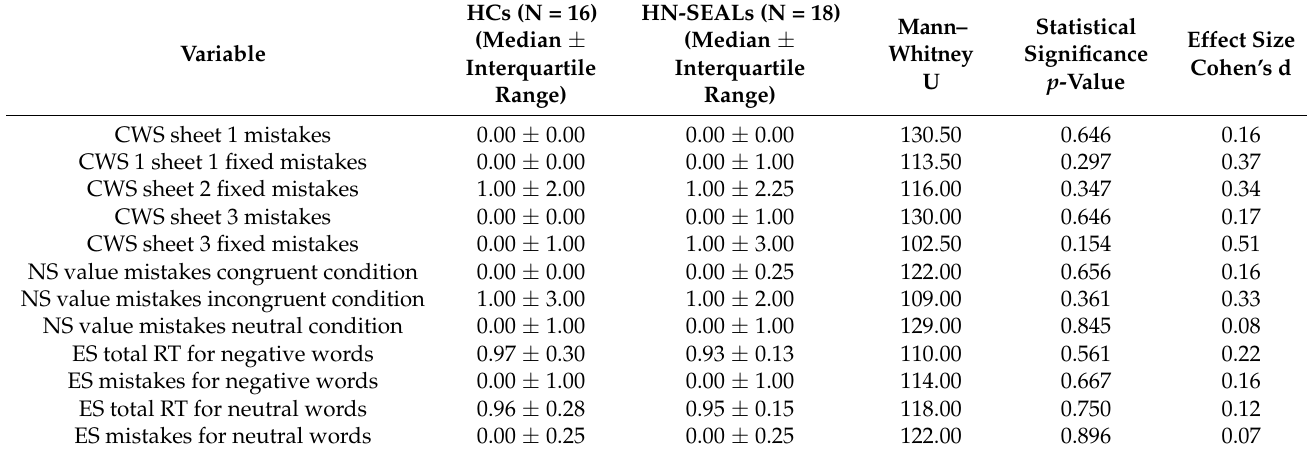
Table 4. Mann–Whitney U test for equality of Stroop median values between HN-SEALs and